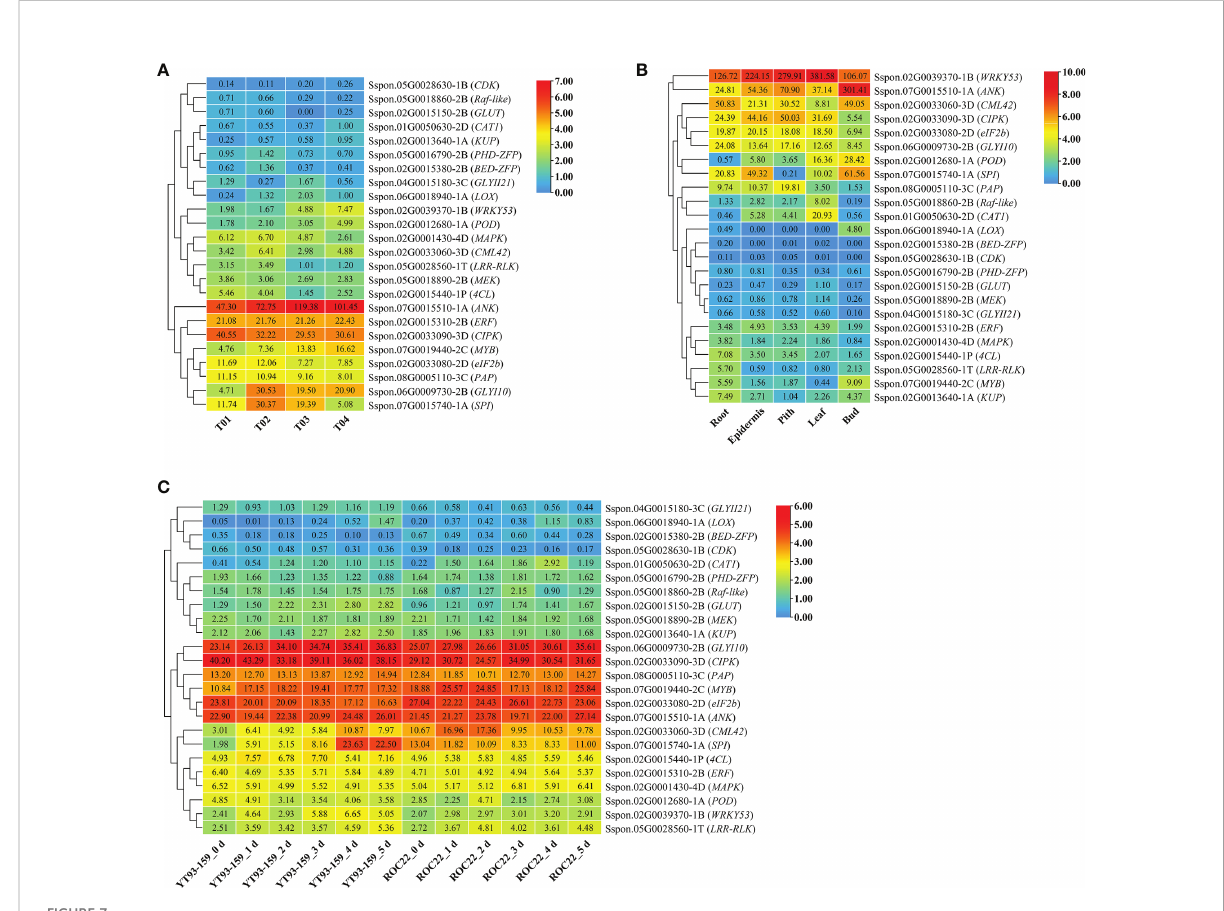
FIGURE 7 Expression patterns of key genes based on BSR-Seq database (A) in ROC22 (B) , and under the stress of sugarcane smut pathogen (C)